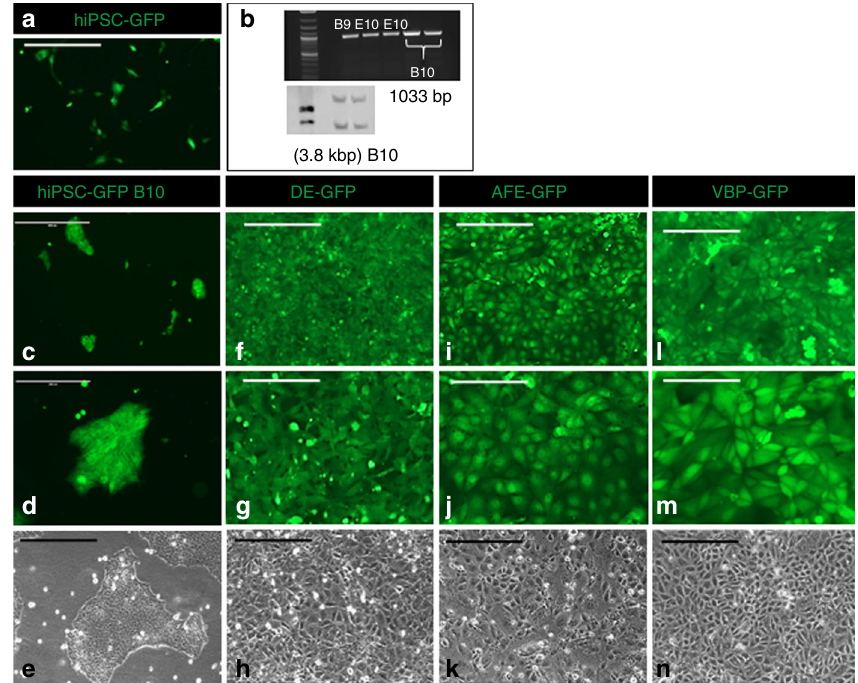
Fig. 1 Green fl uorescent protein incorporation into the genome of hiPSC. a Green GFP-positive colonies after nucleofection. b Con fi rmation of correct GFP insertion with the polymerase chain reaction and southern blotting. c – e Colonies of green GFP-positive B10 clones selected for differentiation ( c ). A detail of the B10 GFP + colony ( d ). A bright- fi eld image of B10 GFP + colony ( e ). f – n show stable and persistent GFP insertion throughout cell differentiation, including bright fi eld images, in the DE ( f – h ), AFE ( i – k ), and VBP before seeding on the collagen constructs ( l – n ). Scale bars in the panels of a , c , e , f , h , i , k , l , n = 400 μ m. Scale bars in the panels of d , g , j , and m = 200 μ m. AFE anterior foregut endoderm, DE de fi nitive endoderm, GFP green fl uorescent protein, hiPSC human induced pluripotent stem cells, VBP vocal fold basal progenitors. Source data provided as a Source Data fi